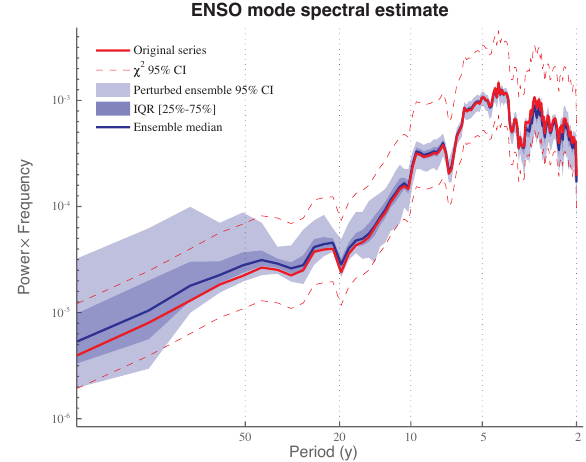
Fig. 6. Spectral density of the ENSO mode PC for θ = 0 . 001. Com- pare to Fig. 5, bottom